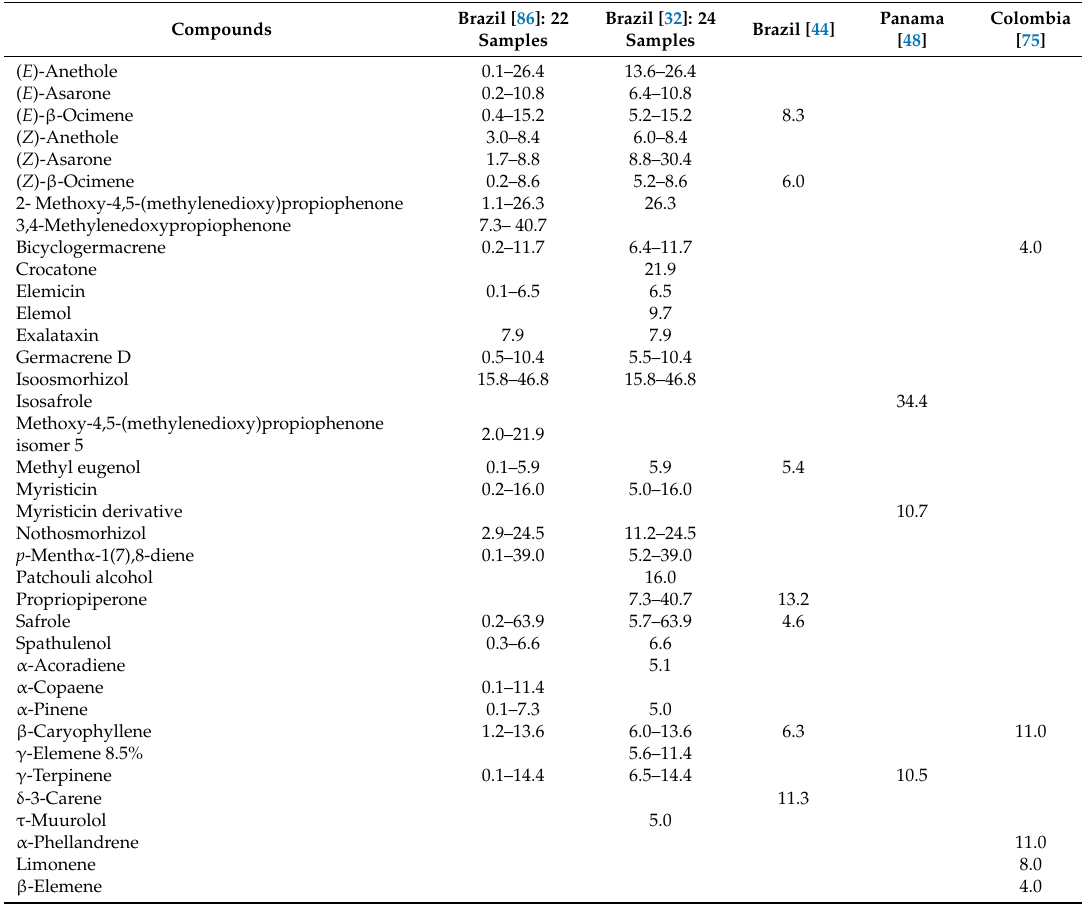
Table 20. Chemical compositions (%) of Piper marginatum Jacq. leaf essential oils. Compounds